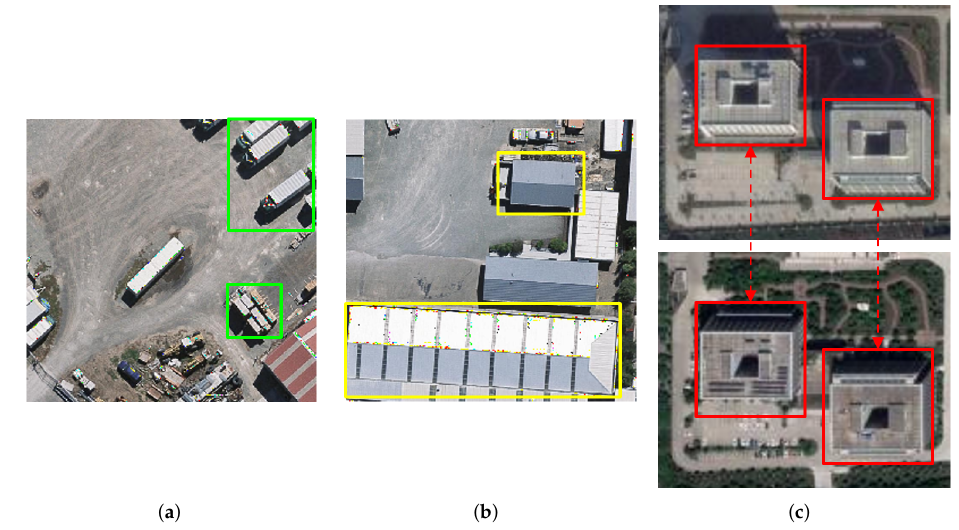
Figure 1. The existing problems of CD tasks (take the building CD task as an example). ( a ) Ground objects that are similar to buildings, such as the trucks and containers in the green rectangles. ( b ) Build- ings with large scale differences. ( c ) The offset of buildings caused by different viewing